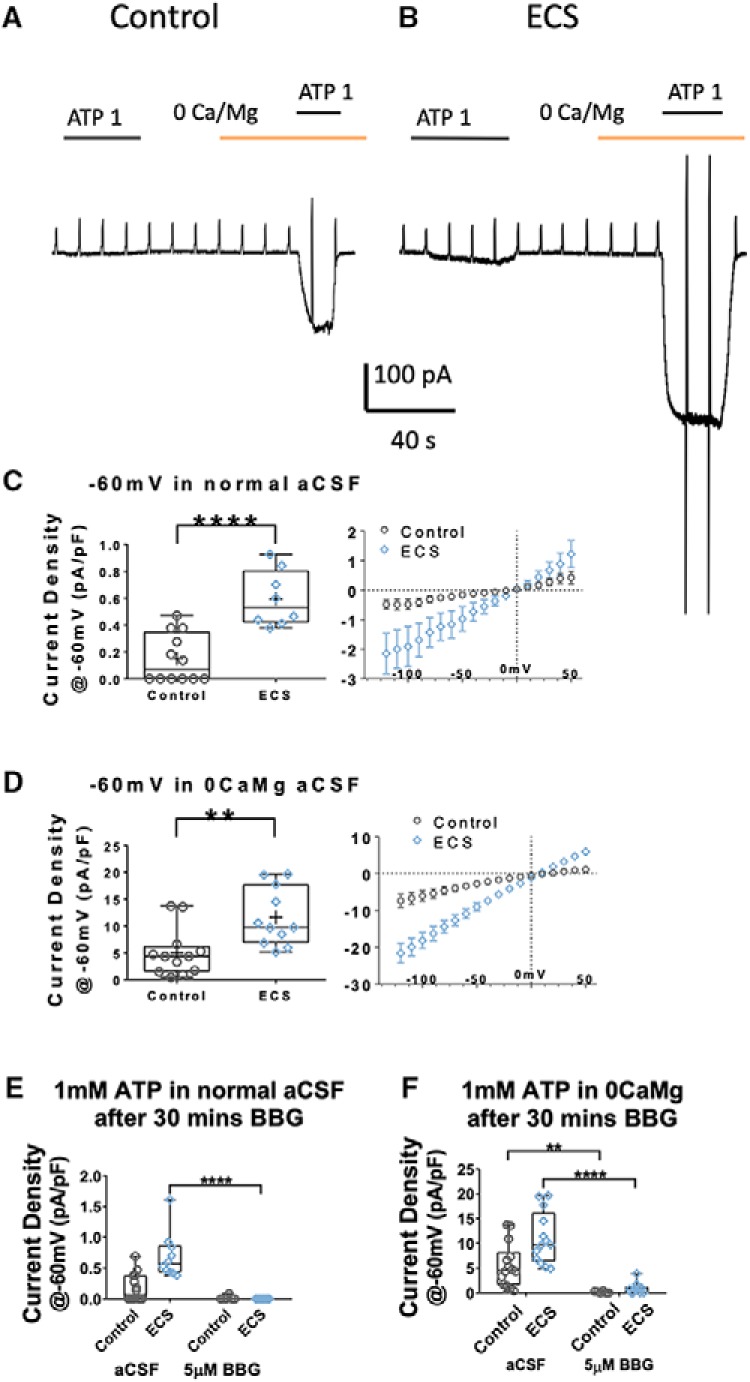
ECS enhanced P2X7 current density in CA1sr microglia. A, B, Representative voltage-clamp traces showing the currents induced by local application of 1 mM ATP (black bar) in normal or 0CaMg aCSF (yellow bar), in microglia in slices from sham (A) versus ECS (B) animals. Cells were held at Vm = −60 mV, with 500 ms ramps from −120 to +50 mV every 10 s. C, D, Peak current density (current amplitude/cell capacitance, pA/pF) of 1 mM ATP-evoked currents in normal (C) and divalent cation-free/0CaMg aCSF (D) at Vm = −60 mV. ECS resulted in significantly increased current densities under both recording conditions. Panels on the right represent the average ATP-induced current/voltage relation obtained by subtracting the I/V curve obtained before from that obtained during the ATP application. As is expected for P2X-mediated currents, the I/V relation is linear and reverses around 0 mV. E, Peak current density (current amplitude/cell capacitance, pA/pF) of 1 mM ATP-evoked currents in normal aCSF at Vm = −60 mV, with or without preincubation in the specific P2X7 antagonist BBG. BBG significantly reduced the current density evoked by 1 mM ATP in normal aCSF in ECS cells only. F, Peak current density (pA/pF) of 1 mM ATP-evoked currents in divalent cation-free/0CaMg aCSF at Vm = −60 mV, with or without BBG preincubation. BBG significantly reduced the current density evoked by 1 mM ATP in 0CaMg aCSF in both control and ECS cells. **p < 0.01, ****p < 0.0001.